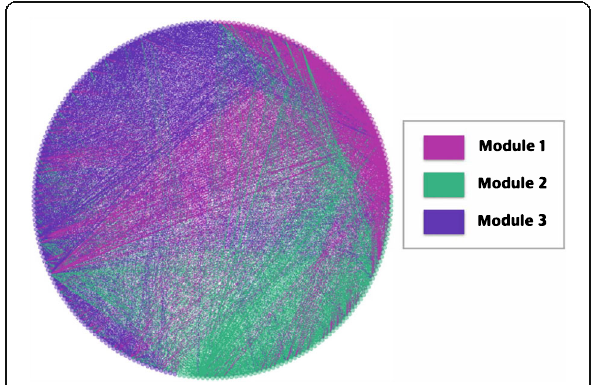
Fig. 2 Herb network of alopecia prescription based on modularity